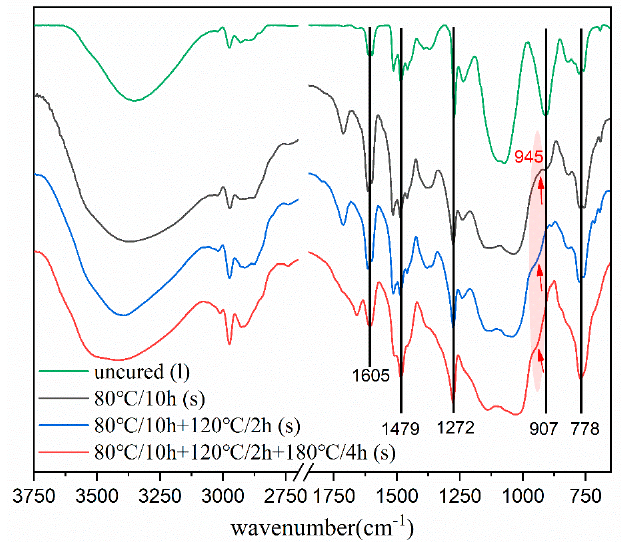
Figure 5. FTIR spectra for SPF ‐ 4 at different curing stages.